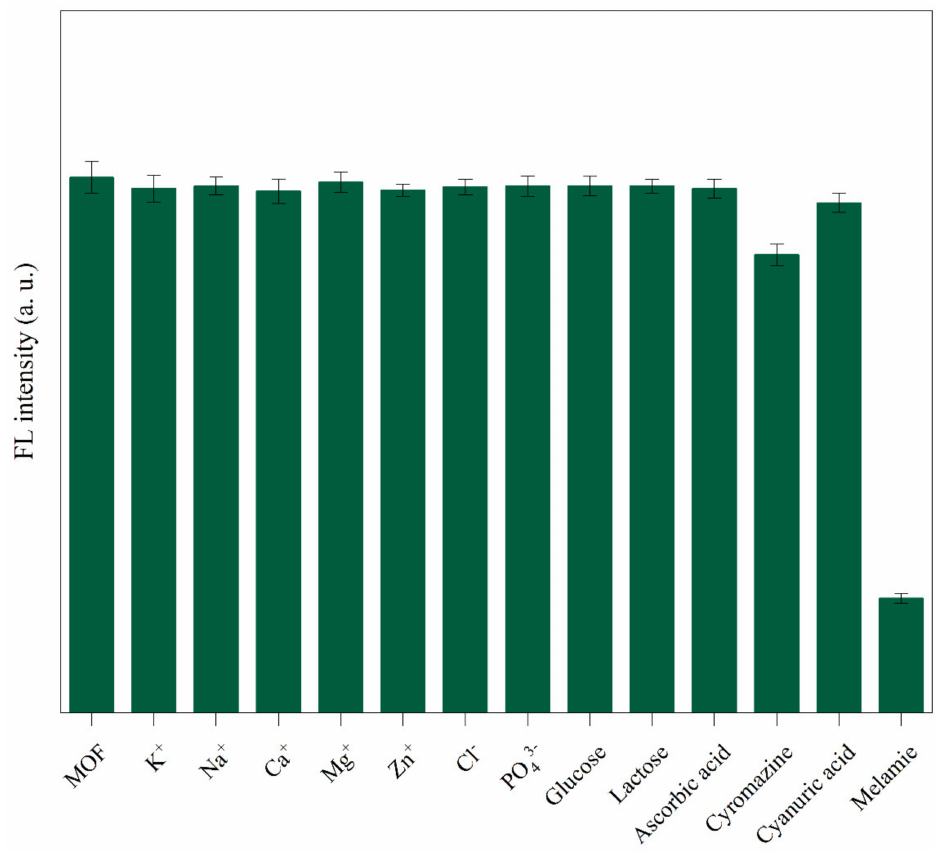
Figure 9. The relative fluorescence intensity of Tb@NH 2 -MIL-253 (Al) MOF aqueous suspension toward melamine or/and different